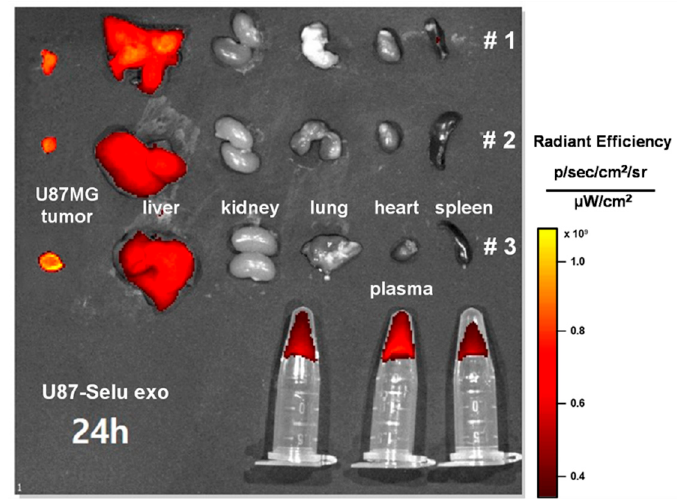
Figure 9. In vivo biodistribution of U87-Selu exo. A strong fluorescence signal was found in the tumor and liver, but not in other organs; # means independent mouse number. n = 3.